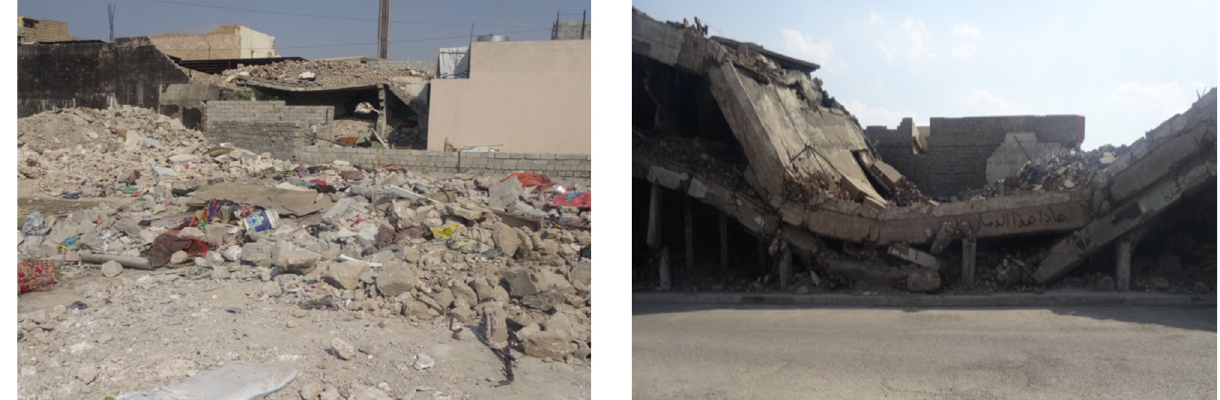
Fig. 10. Mixed rubble (left); Clean rubble